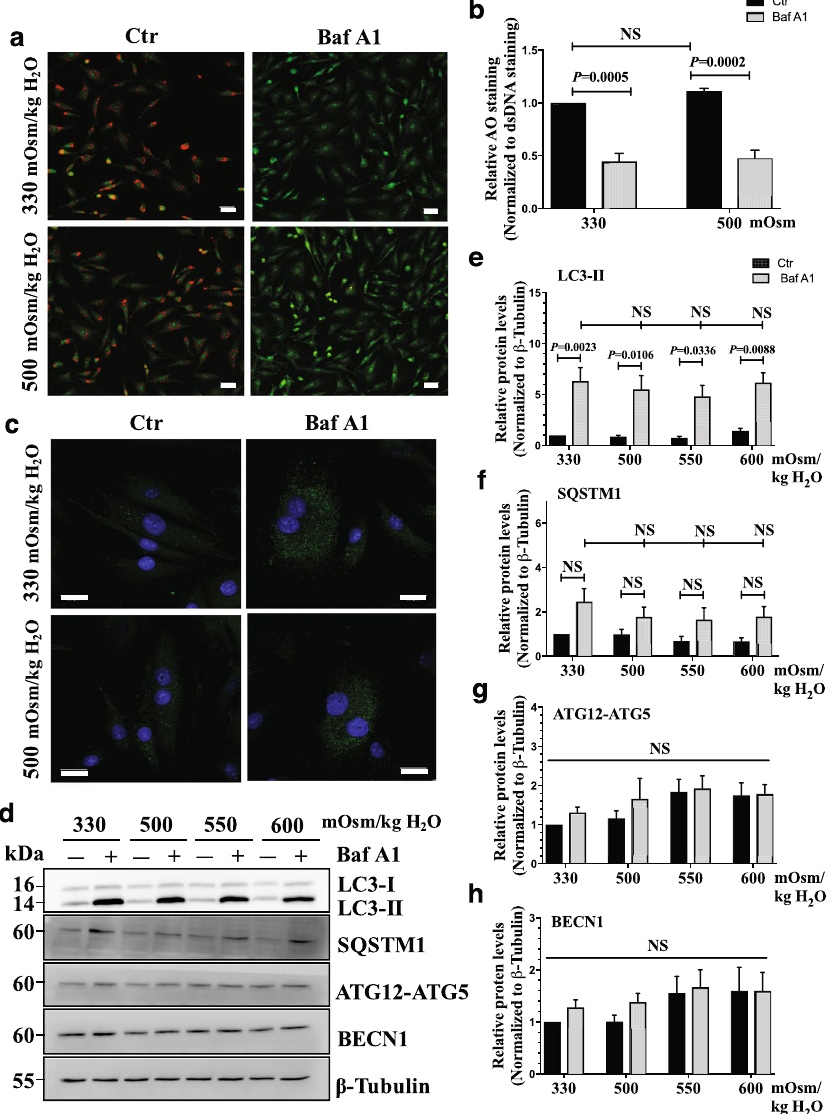
Figure 5. Hyperosmolarity does not influence autophagic flux in NP cells. ( a ) Acridine orange staining of NP cells cultured under iso- (330 mOsm/kg H 2 O, top row) or hyperosmotic (500 mOsm/kg H 2 O, bottom row) condition, treated with (right) or without (left) bafilomycin A1. Hyperosmotic stimulus alone showed no change in number of acidic organelles. Bafilomycin A1 significantly reduced the acridine orange staining irrespective of osmolarity. Scale bar, 35 μ m. ( b ) Quantification of acridine orange staining confirmed that hyperosmolarity had no effect on the number of acidic organelles. ( c ) LC3 immunofluorescence staining of NP cells cultured under hyperosmolarity with or without bafilomycin A1 treatment. Hyperosmotic stimulus did not upregulate LC3-positive autophagosomes. Scale bar, 20 μ m. ( d ) Western blot analysis of NP cells cultured under increasing osmolarity (330–600 mOsm/kg H 2 O) with or without bafilomycin A1 treatment. The accumulation of LC3-II with bafilomycin A1 treatment was similar under iso- and hyperosmotic conditions. SQSTM1 also showed a trend of accumulation with bafilomycin A1 treatment under all conditions. The levels of ATG12-ATG5 and BECN1 remained unaltered between the experimental groups. ( e – h ) Densitometric analyses of multiple Western blots shown in ( d ). Bars represent mean ± SEM (n = 5). Two-way ANOVA with Tukey’s multiple comparisons test was used to determine statistical significance. NS, non-significant. BafA1, bafilomycin A1. Western blot images were cropped and acquired under same experimental conditions. See Supplementary Fig. S1 for examples of uncropped